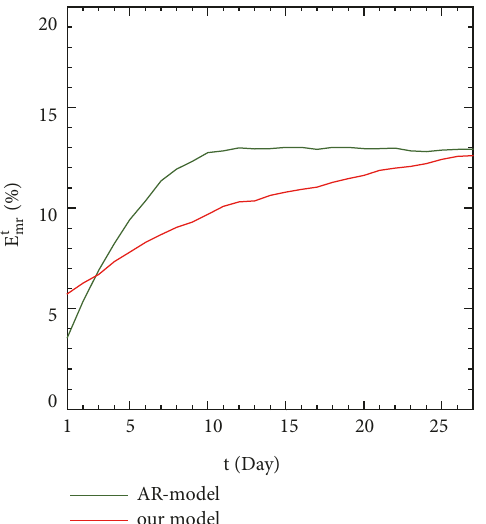
Figure 8: The E t mr of AR-model (green line) and our method (red line) during 2012-2013 for 1-27 days.